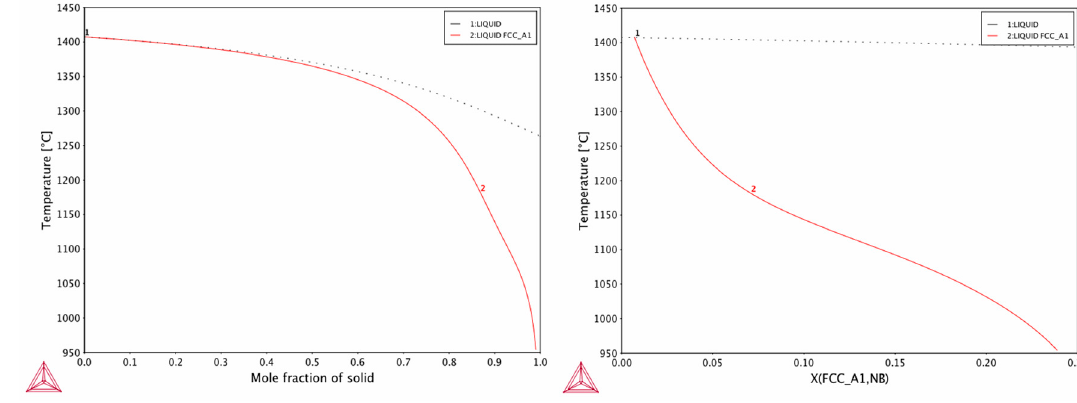
Figure 18. Scheil solidification plot of Ni–0.6Fe–0.035Nb (at. fraction) model ternary alloy.